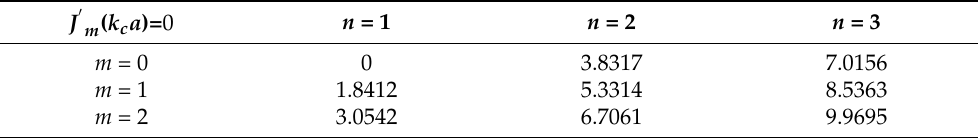
Table 3. Values of (cid:1868) (cid:3040)(cid:3041) for TM modes of circular waveguide . Table 3. Values of p mn for TM modes of circular waveguide.